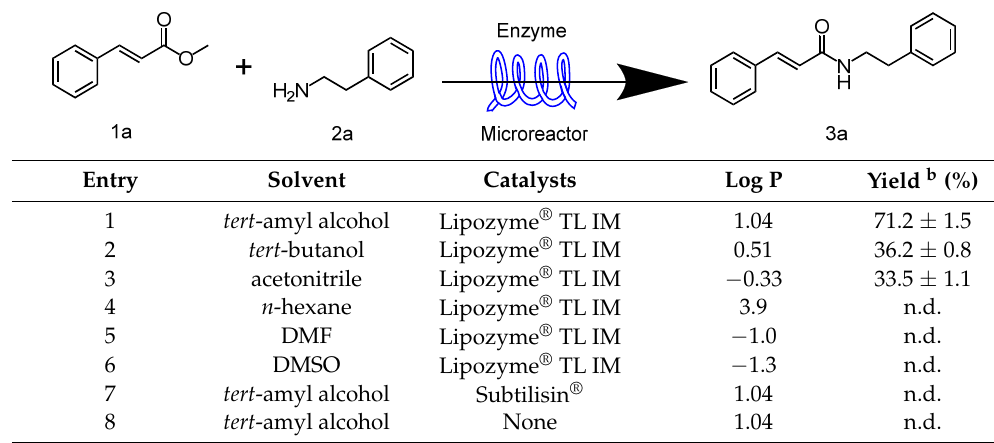
Table 1. The effect of reaction media and catalyst on the enzymatic synthesis of N-phenethylcinnamamide in continuous-flow microreactors a .